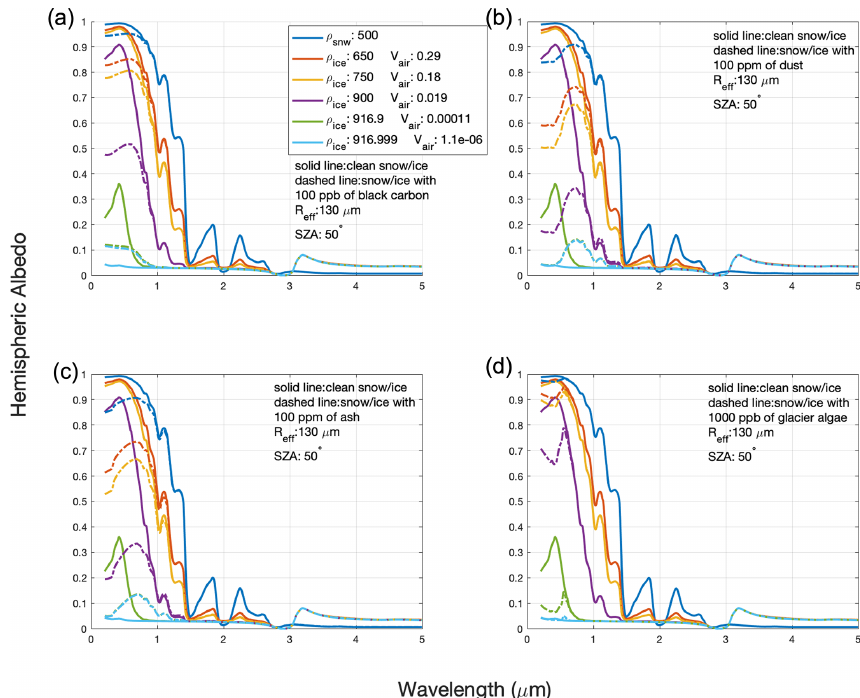
Figure 7. Model spectral albedo of various snow and ice surfaces with LACs. The model configuration of LAC-free surfaces (solid lines) is outlined in Fig. 3, and spectral curves are for a snow grain/air bubble radius of 130µm. Dashed lines are the same with the addition of LACs. (a) Spectral albedo of various snow and ice media with and without 100ppb of uncoated black carbon. (b) As in panel (a) but with and without 100ppm of volcanic ash with a radius of 1.25–2.5µm. (c) As in panel (a) but with and without 100ppm of GrIS dust species with a radius of 1.25–2.5µm. (d) As in panel (a) but with and without 1000ppb of dry glacier algae with a length of 40 and width of 4µm (Cook et al.,